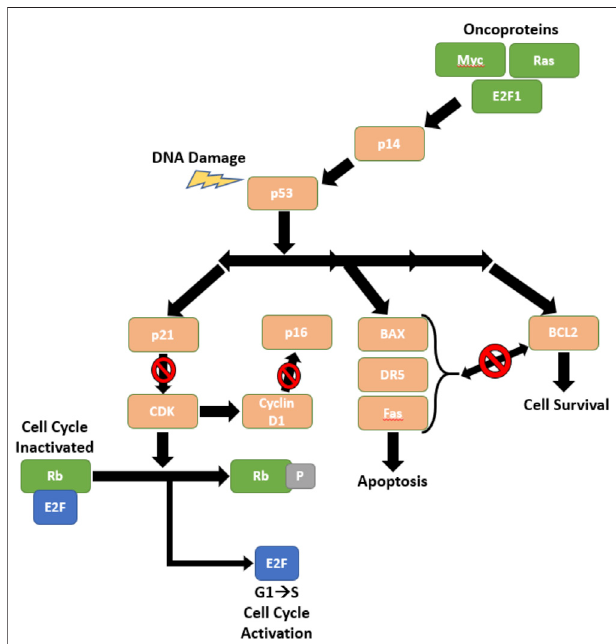
FIGURE 1 | The Role of p53 and Rb in Regulating Cell Cycle